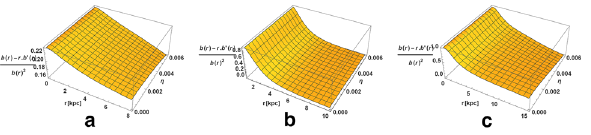
(cid:3) ( r ) Fig. 3 The function b ( r ) − r × b with respect to r ( kpc ) and η is plotted b 2 ( r ) by using ρ 0 = 0.004 kpc − 2 , r 0 = 2 kpc for a NFW profile : r th = 1 . 7 Fig. 5 NEC with respect to r ( kpc ) and η is plotted by using ρ 0 = 0.004 kpc , b Pseudo-Isothermal profile : r th = 1 kpc , c URC profile : r th = kpc − 2 , r 0 = 2 kpc , r th = 1 kpc , k 1 = k 2 = 1, α = 0 . 8, β = 0 . 001 and τ = 2 . 5 for pseudo-isothermal